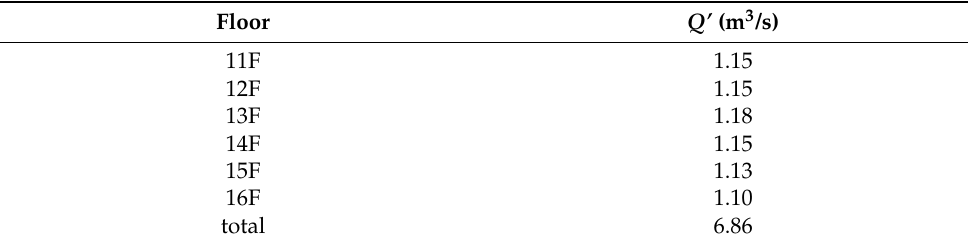
Table 5. Airflow rate on each floor.